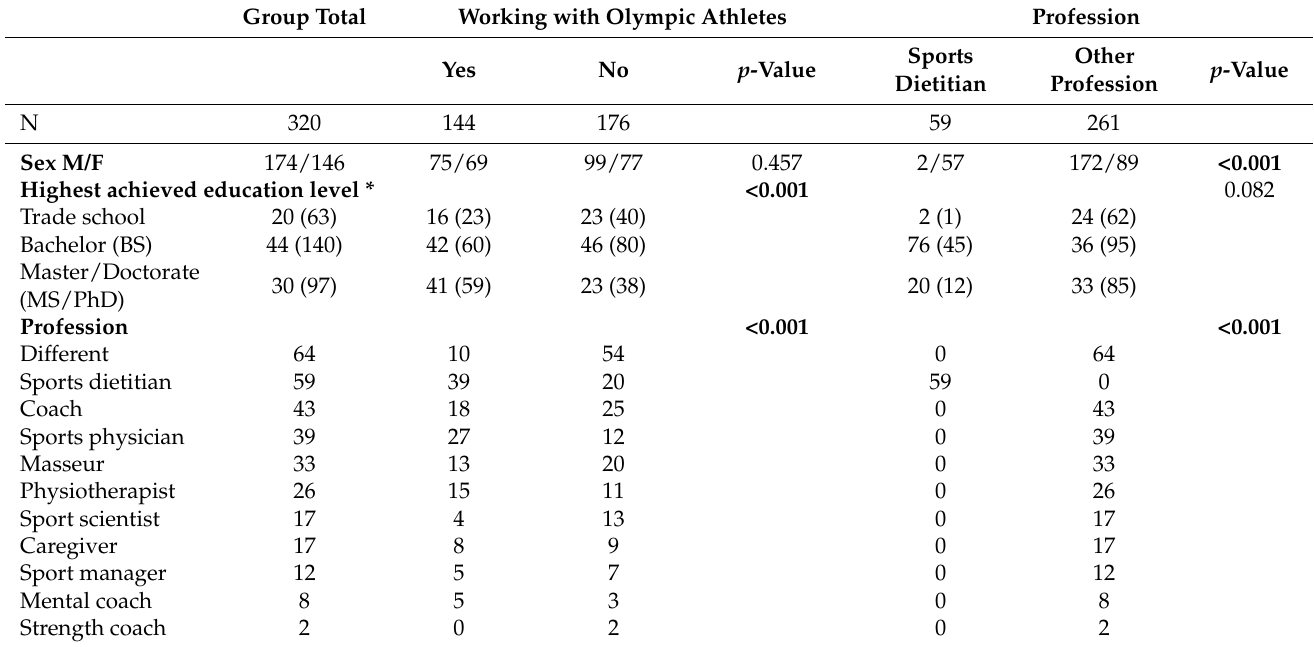
Table 1. Respondent characteristics (Percentage or N or percentage), reported as group total and stratified for professionals working or not working with Olympic athletes and for